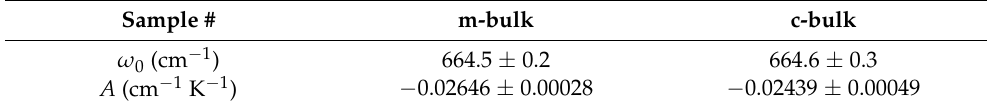
Figure 7. E 2 (high) phonon shifts of samples as a function of temperature at high temperature. Table 4. Fitting parameters for the relations between E 2 (high) phonon shift and temperature of two bulk AlN samples by linear function at high temperature.